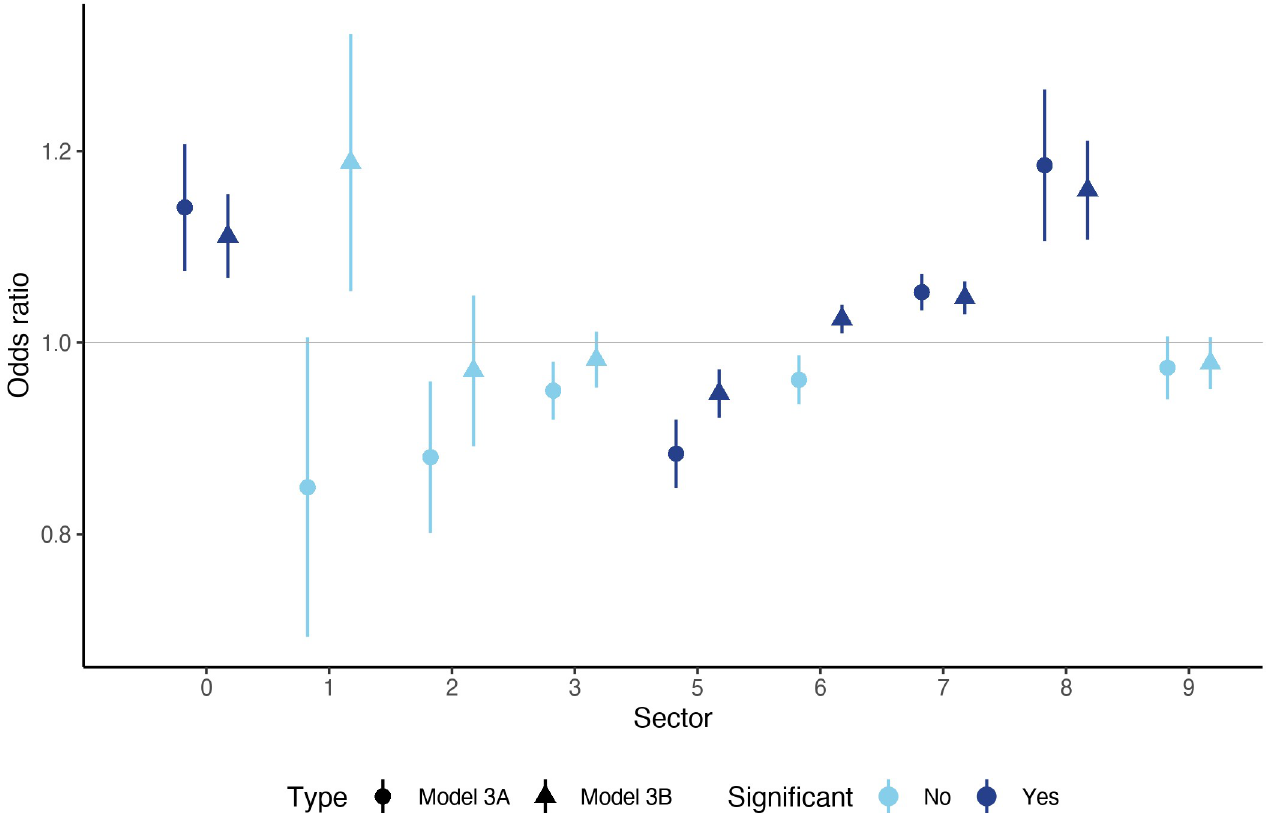
Fig 5. Results of Model 3A and Model 3B. Every marker/line represents the estimated odds-ratio of a given sector in a given model type, measured on the vertical axis. The shape of the markers shows the model type. Circles represent estimated odds-ratios in Model 3A, where every sector is included simultaneously, plus the control variables. Triangle markers indicate the estimated odds-ratios in Model 3B, where sectors enter one-by-one. Dark blue markers/lines show significant odds-ratios at the 10% level, light blue markers/colors represent non-significant results. The length of the vertical lines refer to the robust standard errors around the point-estimates. Sectors are grouped along the horizontal axis, marked by their codes (see Table 1 for reference).